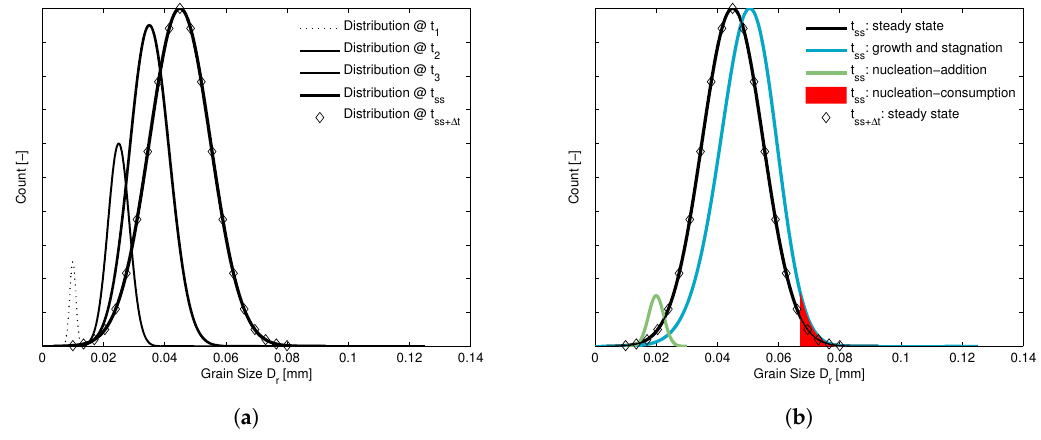
Figure 2. ( a ) Change of the distribution of recrystallizing grains from the onset of DRX to the steady state. ( b ) Detail of the effect of several mechanisms on the distribution at the steady state showing that the net effect is zero, leading to a constant